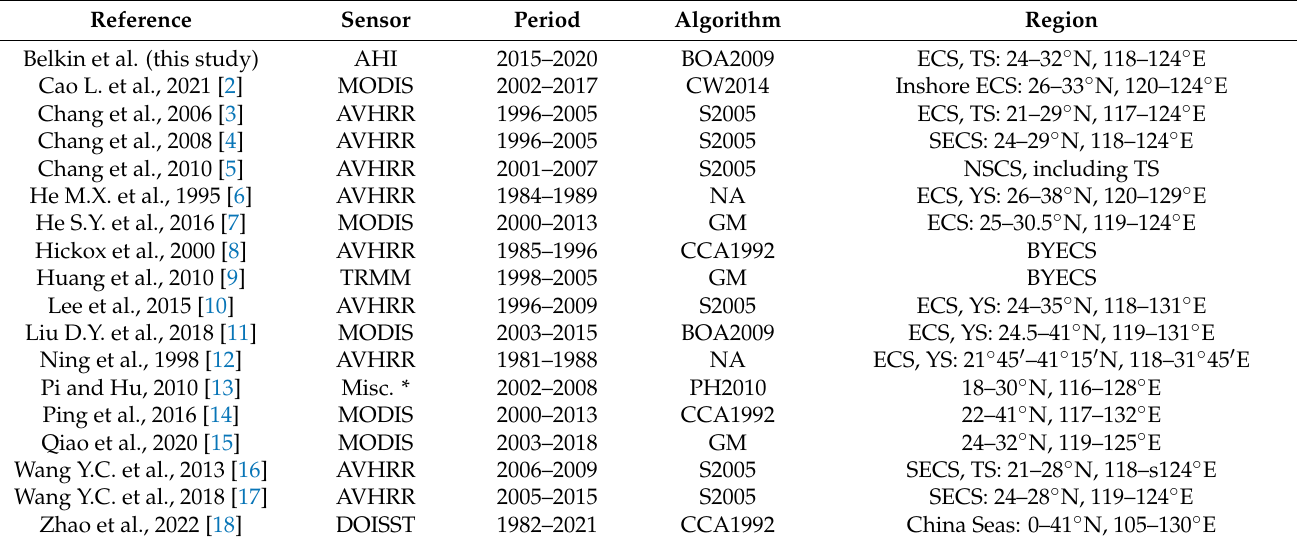
Table 1. Satellite studies of the China Coastal Front in the East China Sea from SST